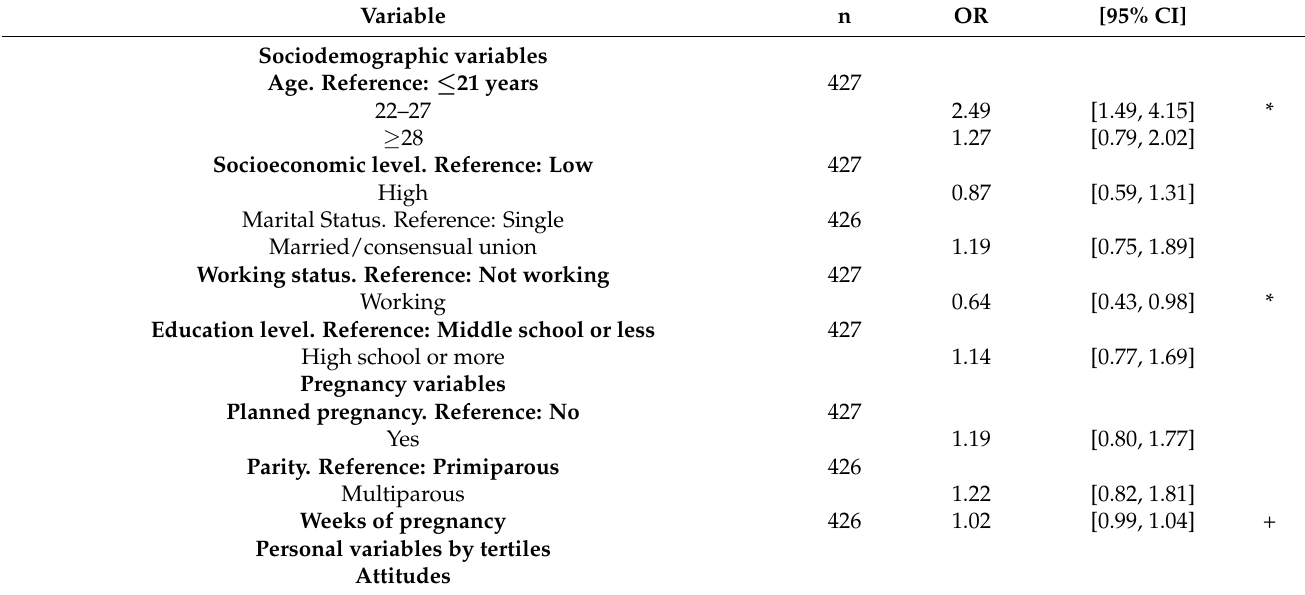
Table 4. Logistic bivariate associations by breastfeeding intention a